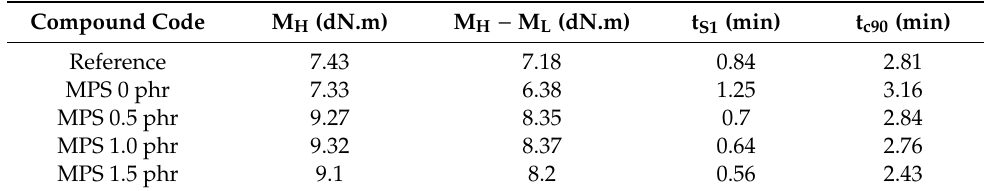
Figure 4. Curing curves of NR/HNT composites in the presence of MNR/MPS as a dual compatibilizer.MPS, modified palm stearin. Table 4. Curing characteristics of NR/HNT composites in the presence of MNR/MPS as a dual